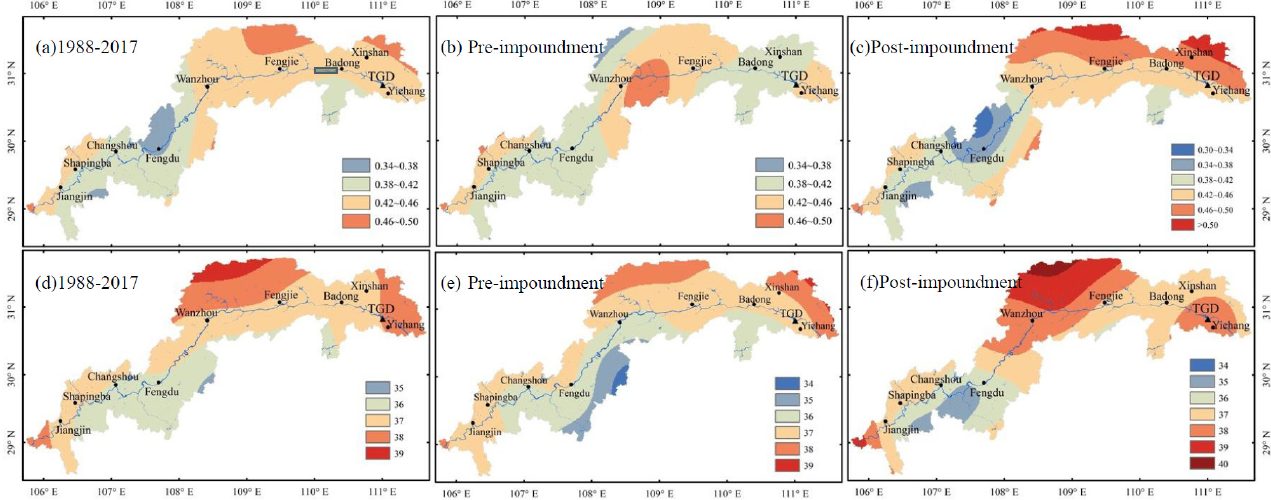
Figure 8. Spatial distribution of ( a ) PCD from 1988 to 2017, ( b ) PCD before the impoundment, ( c ) PCD after the impound- ment, ( d ) PCP from 1988 to 2017, ( e ) PCP before the impoundment, and ( f ) PCP after the impoundment in the TGRA.